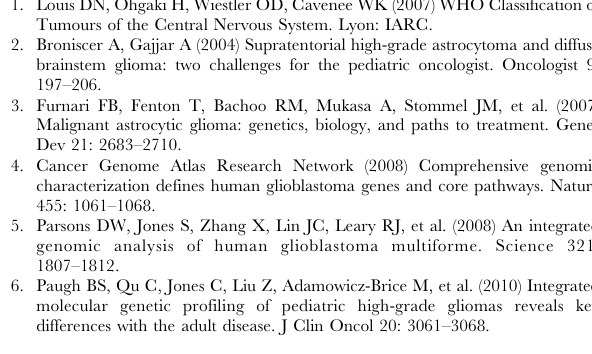
Table S1 Clinicopathological characteristics and mi- crosatellite screening data of all HGG samples. Full QMVR range is provided. (TIFF) Figure S1 Immunohistochemistry of MMR proteins in MSI-positive samples. H&E staining as well as expression of MLH1, MSH2, MSH6 and PMS2 are shown for cases RMH2452, RMH2458 and RMH4816. Original magnification 6 200 (inset 6 600). (TIFF) Figure S2 Immunofluorescence for c H2AX foci in Daudi, Jurkat and Raji cells. Cells were treated with 1.5 Gy IR and allowed to recover for 1 h and 4 h. Higher background levels of DNA damage were observed in Raji cells as seen by the formation of foci in the non-irradiated cells.